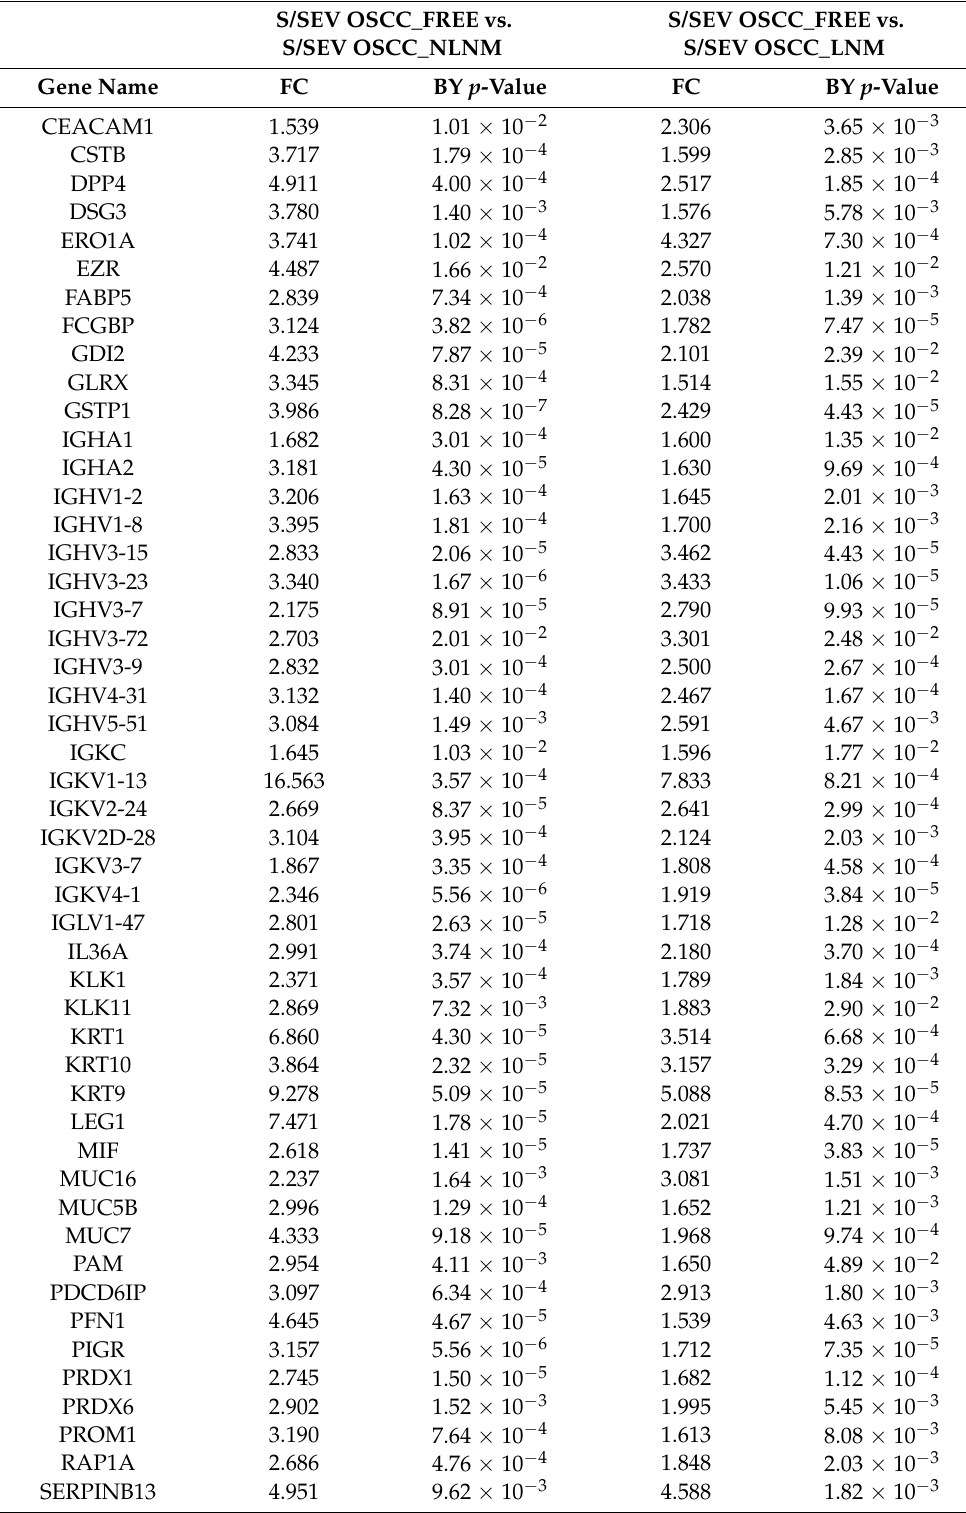
Table 5. Cont . PROTEINS UP-REPRESENTED in S/SEV OSCC_FREE